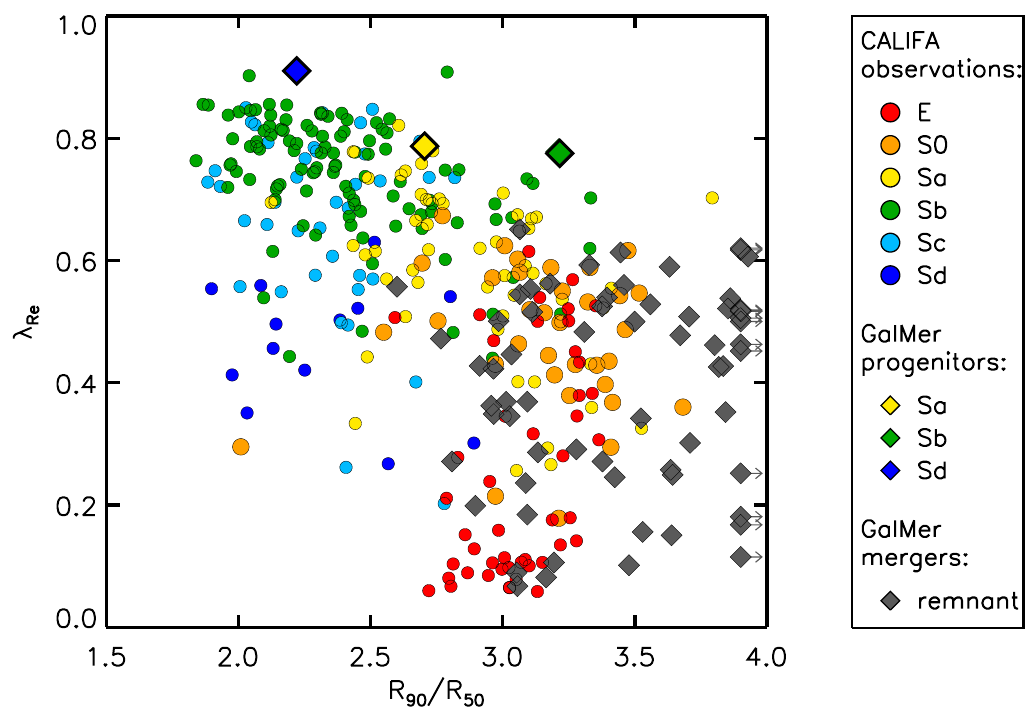
Figure 3. Stellar angular momentum ( λ GalMer simulations (original models and merger remnants), in comparison to CALIFA galaxies. All the parameters correspond to an edge-on